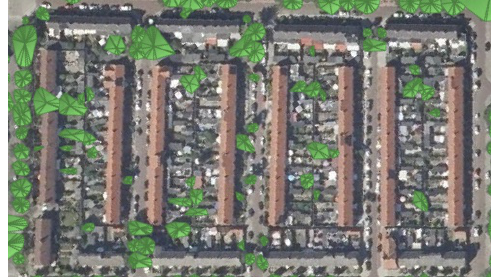
Figure 12. Housing block tree map 2D